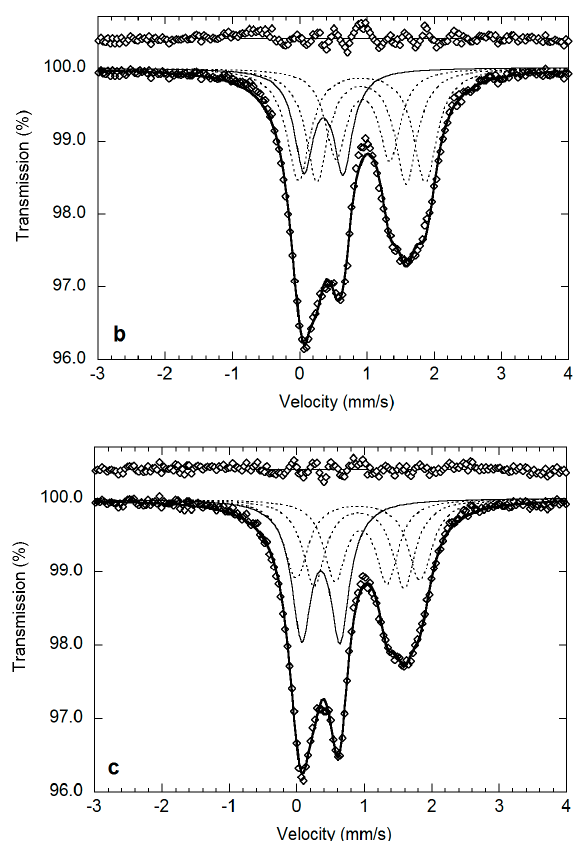
Figure 6. Mössbauer spectra of spinel samples obtained at room temperature showing increasing amounts of Fe 3+ . ( a ) Sample MA425; ( b ) Sample MA273; ( c ) Sample MA44. Stippled line indicates Fe 3+ , thin solid lines indicate Fe 2+ , and thick solid line denotes summed fitted spectrum.